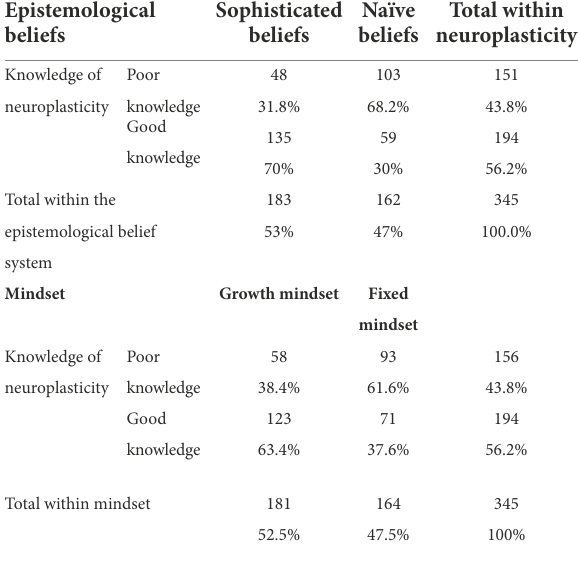
TABLE 5 Distribution of teachers’ mindset and epistemological belief system within the knowledge of neuroplasticity. Epistemological beliefs